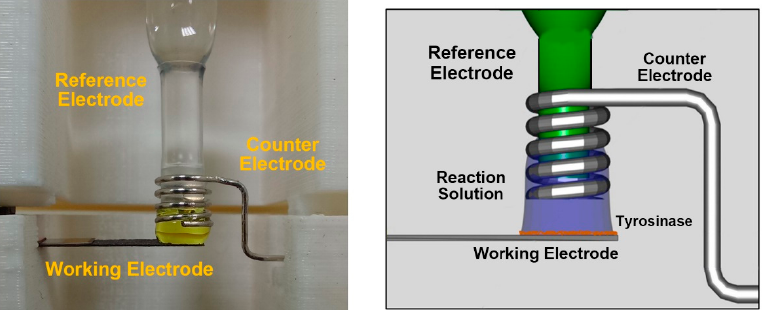
Figure 1. Close up view of the miniature protein tyrosine kinase sensing platform. The organization of working, counter and reference electrodes in the platform was revealed in the picture ( Left ) and the diagram ( Right